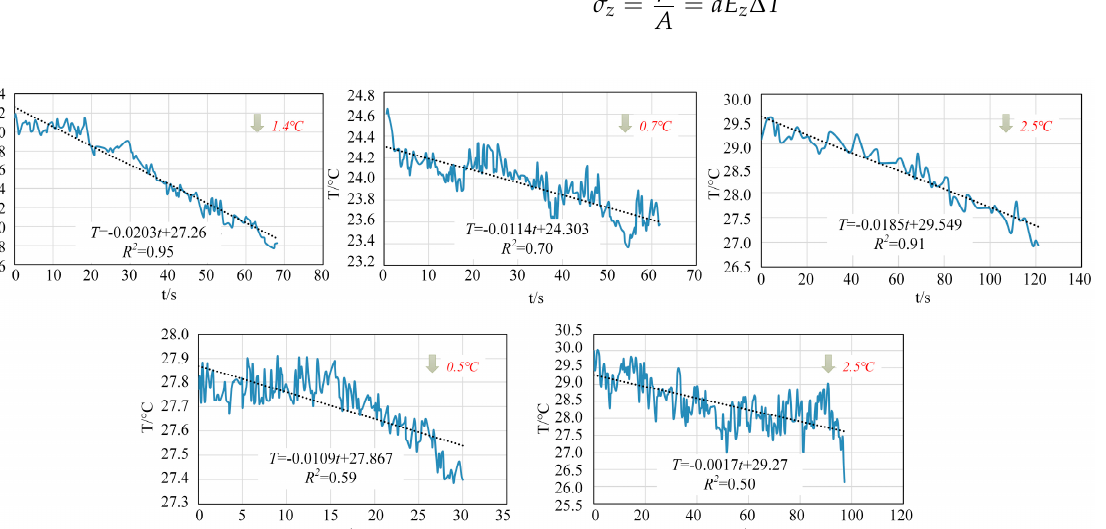
Figure 8. Reduction of the flow section in several buckling modes.